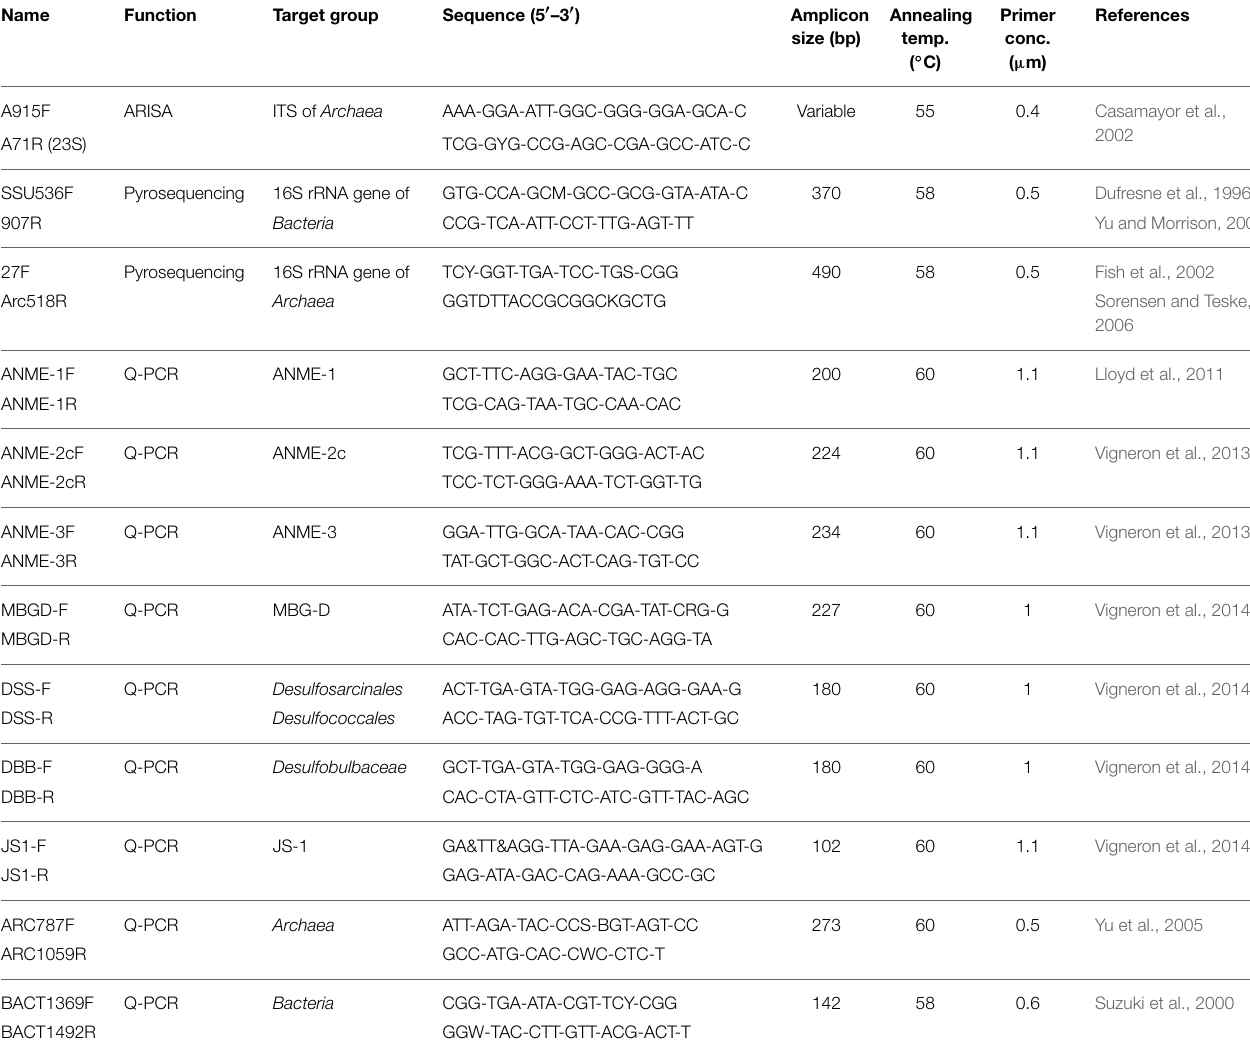
TABLE 1 | PCR primers used for ARISA, 454-pyrosequencing and real-time PCR of 16S rRNA genes.